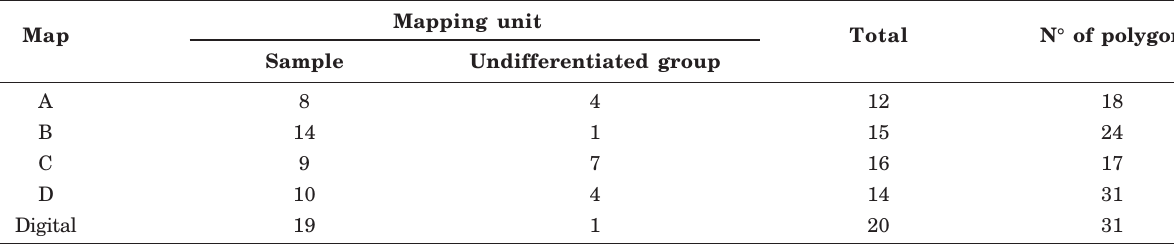
Table 3. Characteristics of the mapping units (MUs)